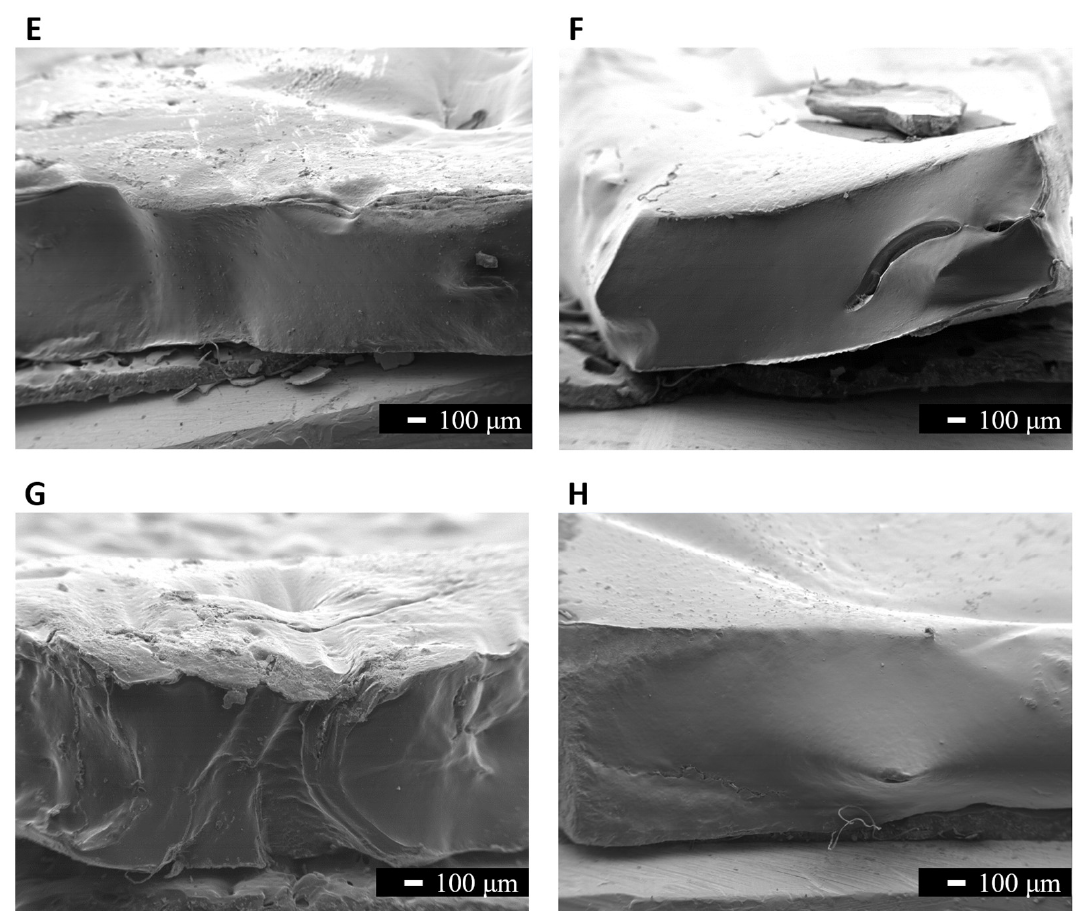
Figure 4. SEM images (3000 × magnification, scale bar 1 µ m) of the surface of hydrogels with formulation CS ( A , B ), and formulation C ( C , D ): before sterilisation ( A , C ) and after sterilisation ( B , D ). Cross-section images (40 × magnification, scale bar 100 µ m) of the hydrogels of formulation CS ( E , F ), and formulation C ( G , H ): before sterilisation ( E , G ) and after sterilisation ( F , H